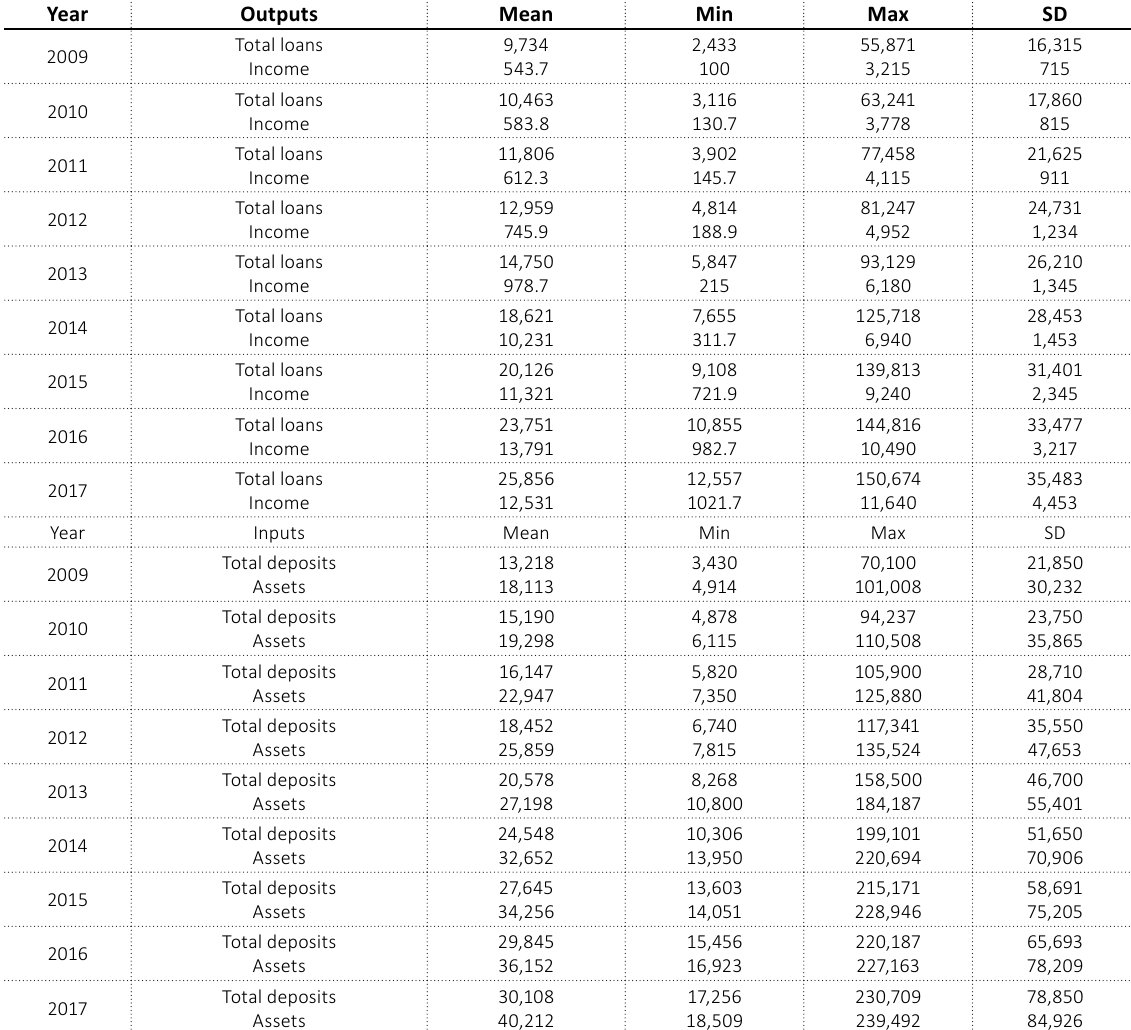
Table 7. Input and output variables after the